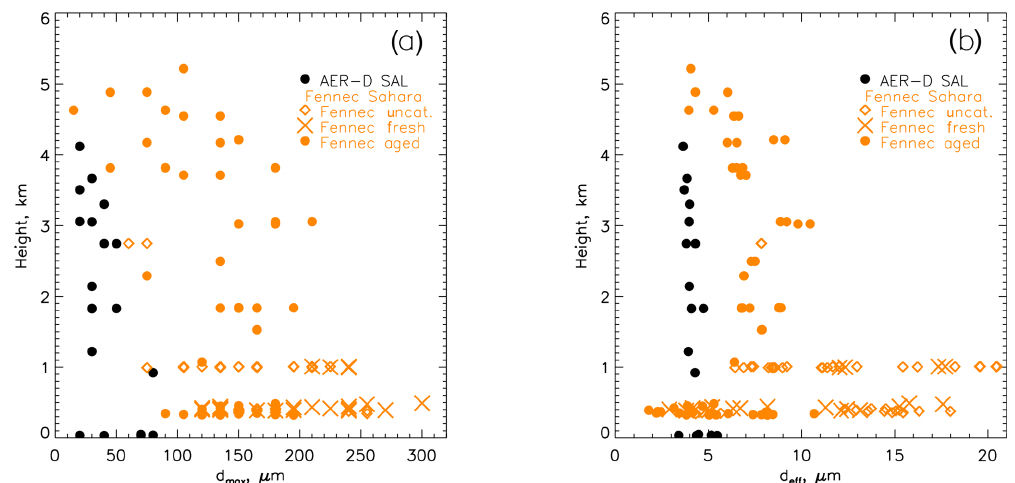
Figure 4. Variation of dust size with altitude from Fennec-Sahara and AER-D-SAL, showing (a) maximum size detected ( d max ) and (b) ef- fective diameter ( d eff ). The d eff uncertainties are 5%, and the d max uncertainties are 10µm for AER-D and 15µm for Fennec. Data are from horizontal flight legs (and therefore not available for